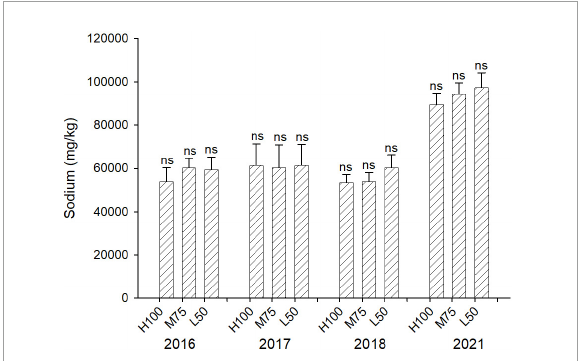
FIGURE4 Concentration (mg/kg DW) of Na in plants of agretti grown for 4 years on saline, B- and Se-laden soil and irrigated at different rates (Et o %) with either low-saline water (2016 and 2017) or saline water (2018 and 2021). Statistical difference was performed to analyze the effect of irrigation levels within each planting year (H100 = high 100% Et o , M75 = medium 75% Et o , and L50 = low 50% Et o ) as described in Table 3 . Values represent average ( n = 12 for 100% Et o , n = 9 for 75% and 50% Et o for planting in 2016; n = 19 for 100% Et o , n = 17 for 75% for planting in 2017; n = 18 for planting in 2018, n = 4 for planting in 2021, direct seeding) and error bars represent standard deviation. Different letters indicate that values differed significantly ( P ≤ 0.05), ns = not significant.